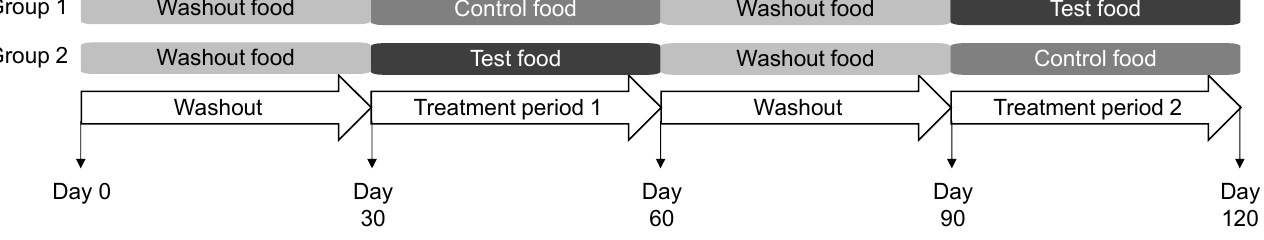
Figure 1. Study design in which dogs consumed the washout, control, and test foods. Each group contained 20